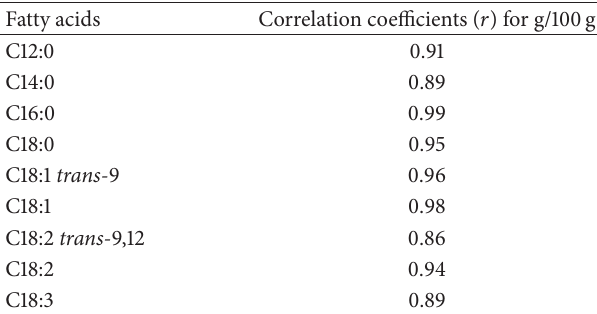
Table 3: Correlation coefficients between the KOCH and TMS-DM